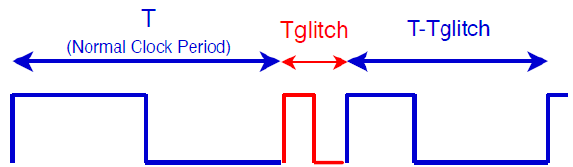
Figure 3. Violating critical path delay by insertion of additional positive clock edge.